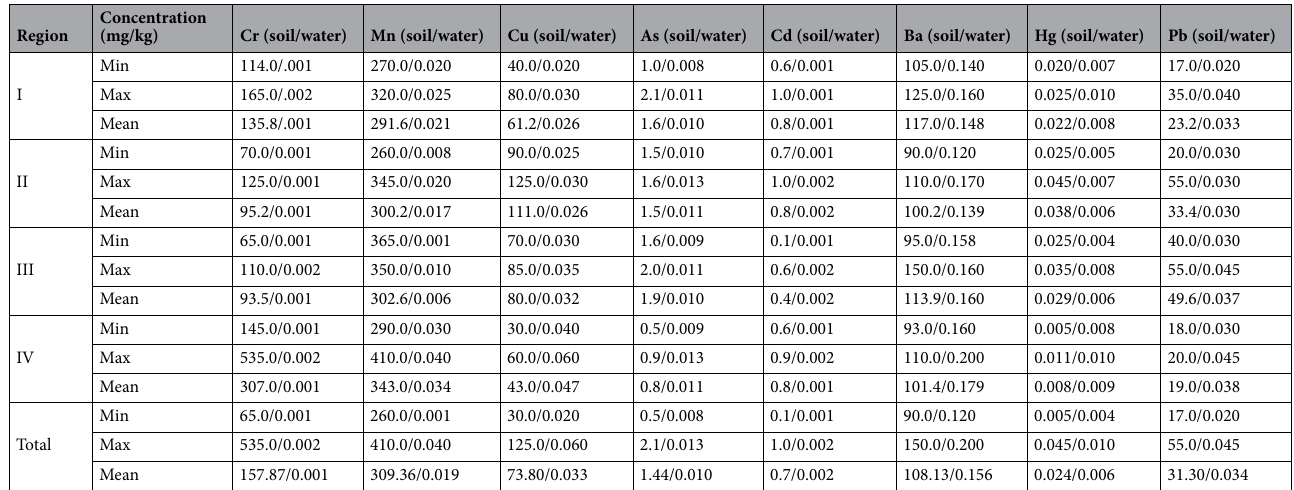
Table 4. Toxic and heavy metals concentration (mg kg −1 ) in soil and water of Sialkot city (n = 20). Five samples each of soil and water from each